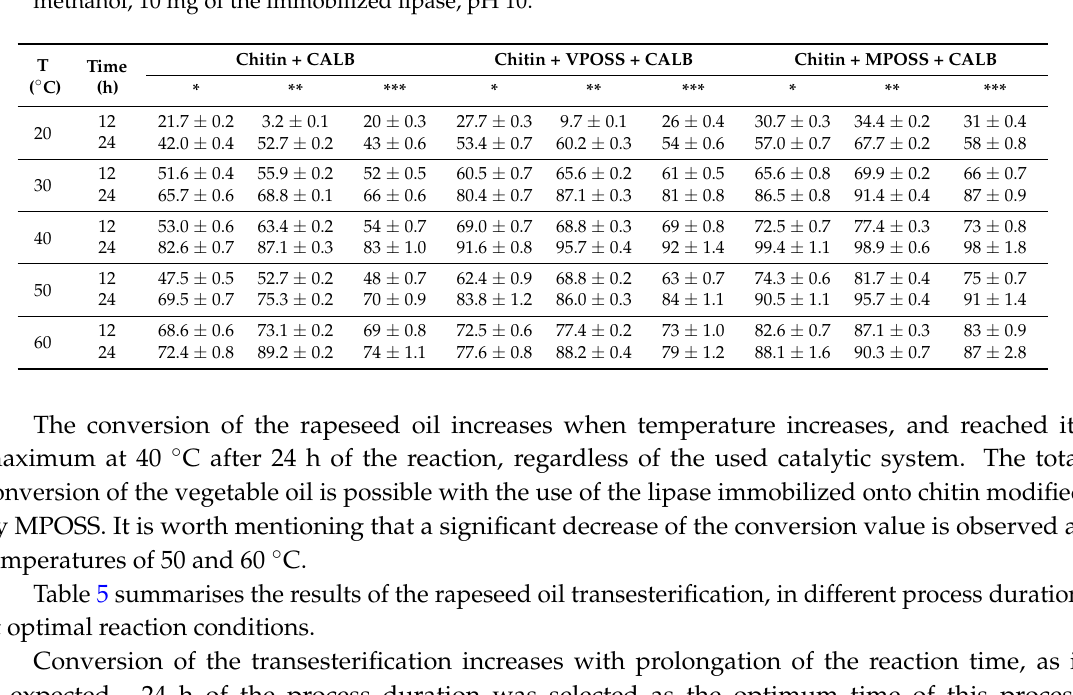
Table 4. Effect of the temperature and reaction time on the chemical composition, * relative content of FAME (%), ** relative content of glycerol (% w / w ), and *** conversion (%) after methanolysis of rapeseed oil. As the relative content, the measured mass of the substance to theoretical mass of the substance after total methanolysis is considered. Reaction conditions: 7.5 cm 3 rapeseed oil, 1.5 cm 3 methanol, 10 mg of the immobilized lipase, pH